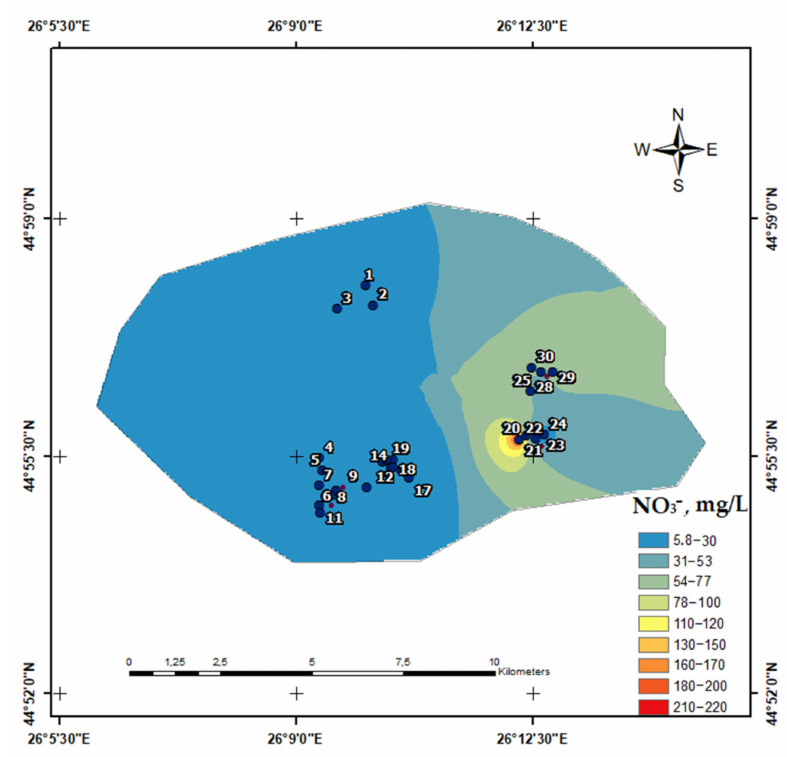
Figure 6. Spatial distribution of NO 3 − in study area (ArcMap 10.5